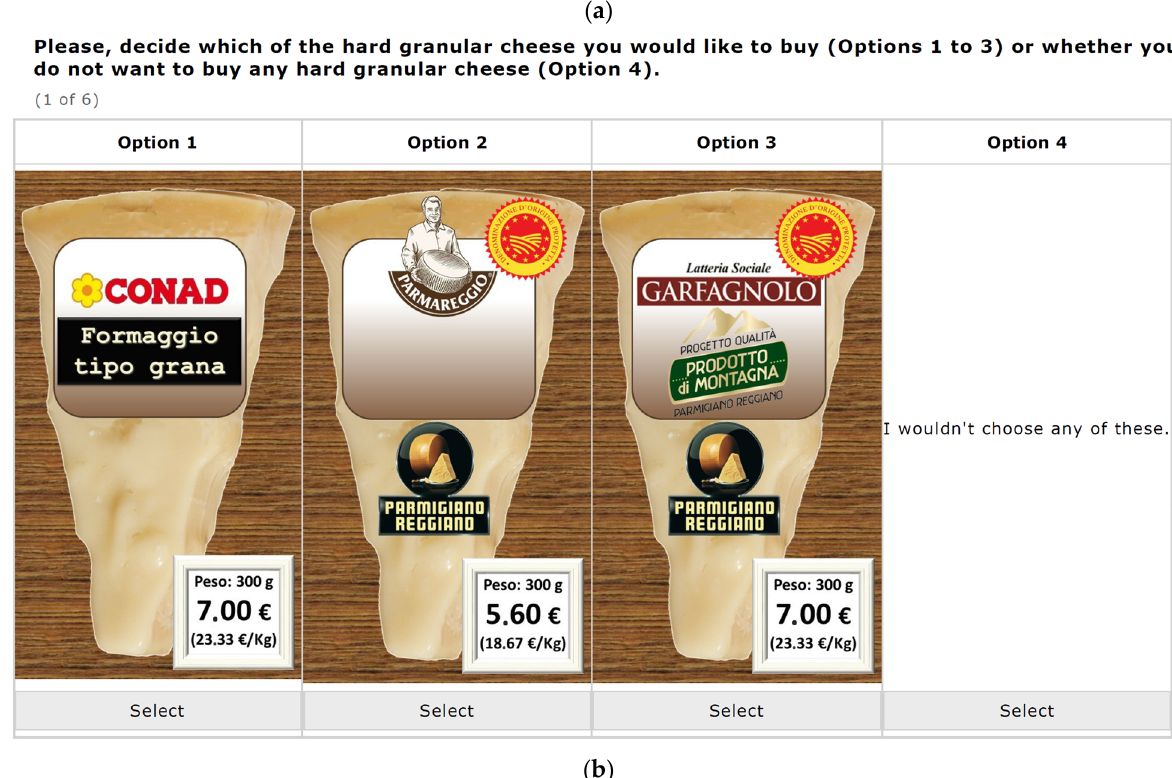
Figure 1. ( a ) An example of choice set in France. ( b ) An example of choice set in Italy.